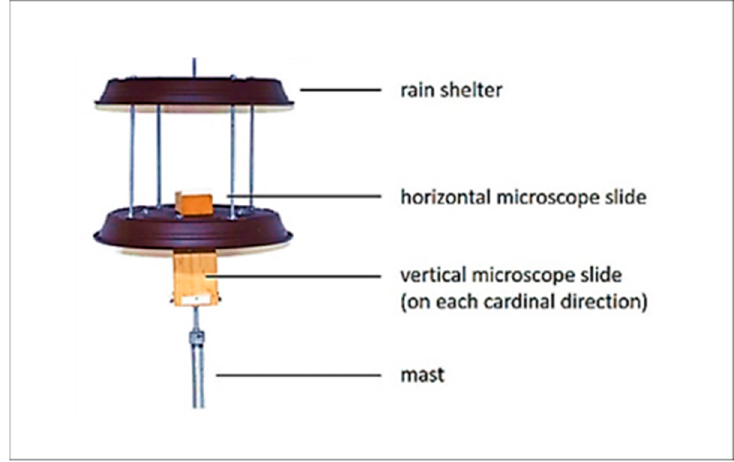
Figure 2. Self-constructed gravimetric pollen trap of the Durham type.